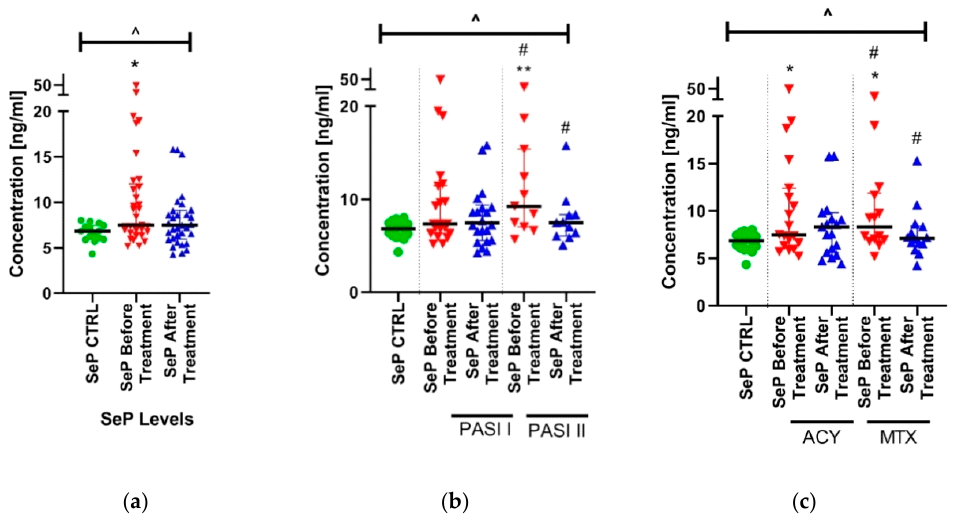
Figure 1. The levels of SeP in the study group before and after total treatment ( a ) compared to controls and divided into subgroups based on PASI ( b ) and undergoing therapy separately with acitretin and methotrexate ( c ). */**/ means the existence of statistically significant difference between patient single group compared to controls with p < 0.05; p < 0.01, respectively. ^ means the existence of a statistically significant difference between all the groups calculated using ANOVA with p < 0.05. # shows the statistical significance between controls and marked patient subgroups when compared using ANOVA with p < 0.05 . SeP—selenoprotein P. (PASI I: n = 22; PASI II: n = 11; ACY: n = 19; MTX: n = 14)